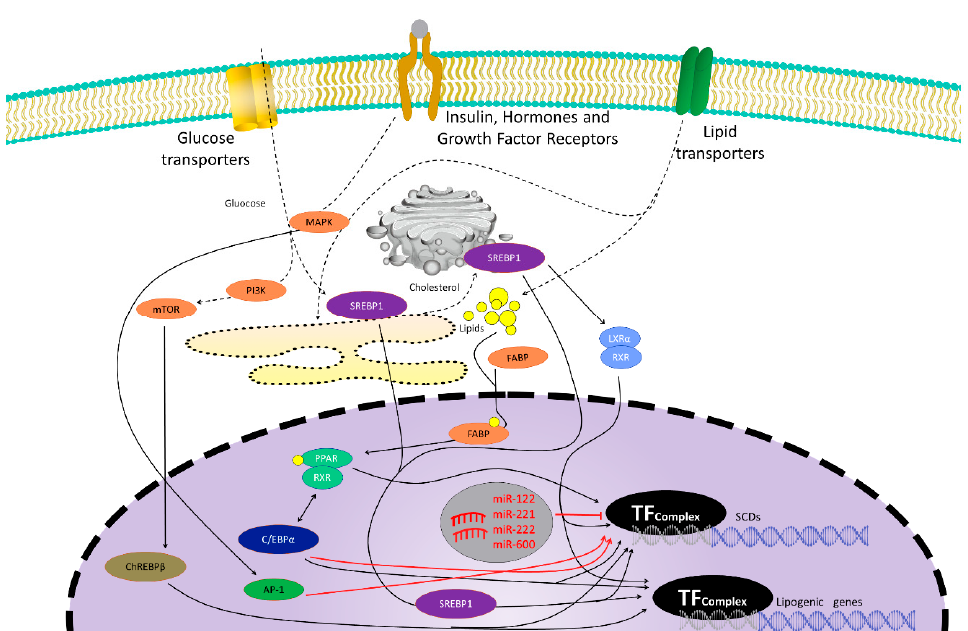
Figure 1 . Genetic control of the stearoyl-CoA desaturase (SCD) family and other lipogenic gene expression. Promoter regions of SCD genes present many transcription factor binding sites, such as sterol regulatory element binding protein 1 (SREBP1), carbohydrate response element binding protein (ChREBP), CCAAT/enhancer-binding protein (C/EBP), liver X receptor (LXR), or peroxisome proliferator-activated receptor (PPAR). Black arrows represent inductive signals while red lines represent repressive signals that negatively modulate SCD genes expression. Glucose uptake or insulin signaling, but also lipid uptake, hormones, or growth factors binding to their receptors, signaling pathways such as phosphatidylinositol 3-kinase (PI3K), mitogen-activated protein kinase (MAPK), mammalian target of rapamycin (mTOR), or endoplasmic reticulum (ER) stress, promote direct or indirect transcription factor binding to SCDs promoters to modulate SCD gene expression. Some microRNAs (mirRNA121, 221, 222, and 600) have been reported to downregulate SCDs expression. Activator protein 1 (AP-1) is a transcription factor that reduces SCD1 expression after leptin stimulation. C / EBP induction can also downregulate SCD1 expression after bacterial